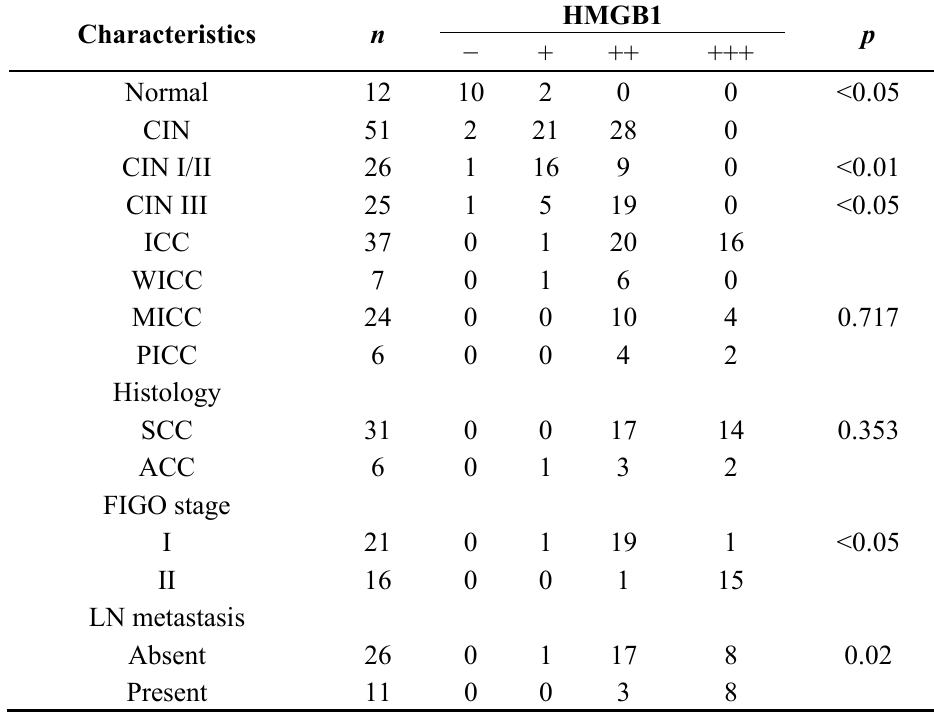
Table 2. Relationship between HMGB1 expression and clinicopathological factors.